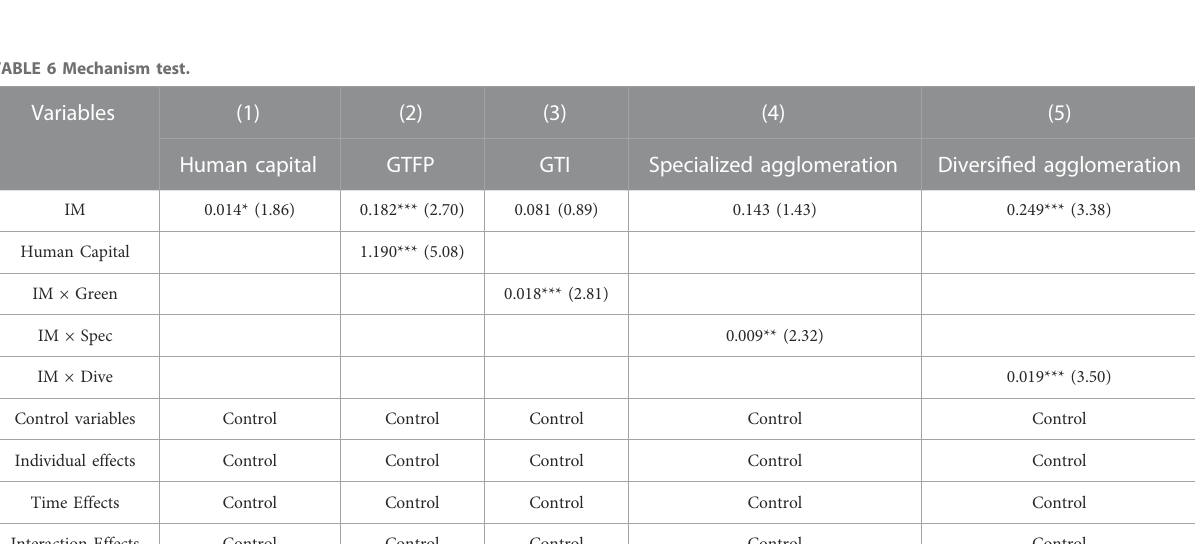
TABLE 6 Mechanism